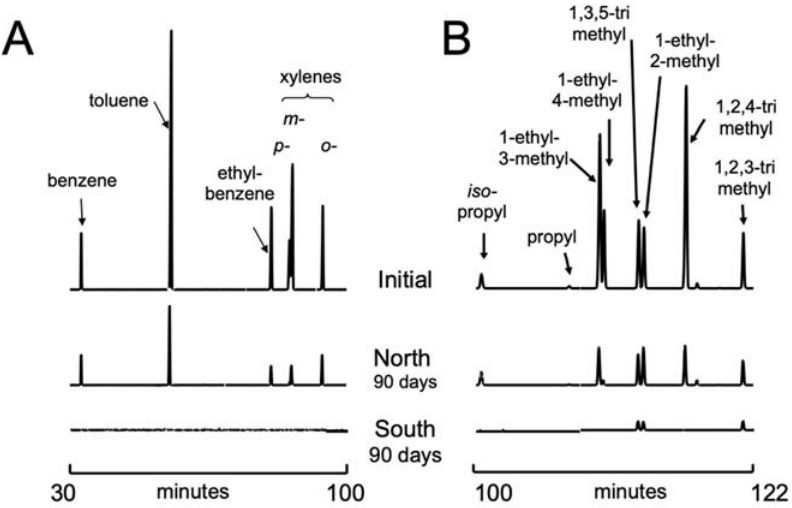
Figure 2. Biodegradation of BTEX ( A ) and the C3-benzenes ( B ) in gasoline in water from the South and North Arms of the Great Salt Lake after 90 days of incubation. Panel ( A ) shows the chromatograms of ions ( m / z ) 78 (benzene) and 91 (toluene and the others), while Panel ( B ) shows the chromatograms for m/z = 105.